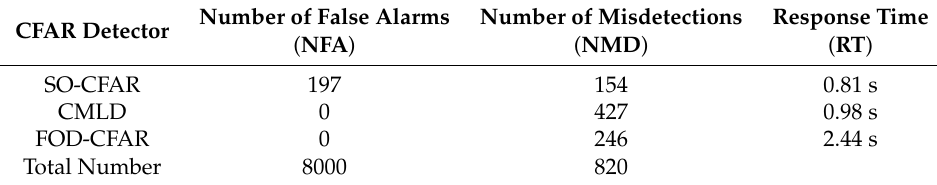
Table 5. Performance analysis of the FOD-CFAR, SO-CFAR and CMLD on the real